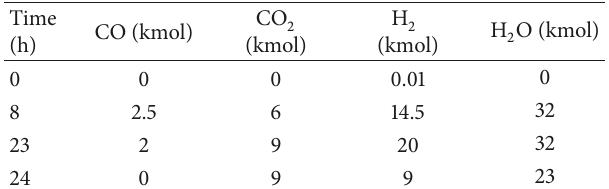
Table 5: Amounts of gases at different times after a water ingress